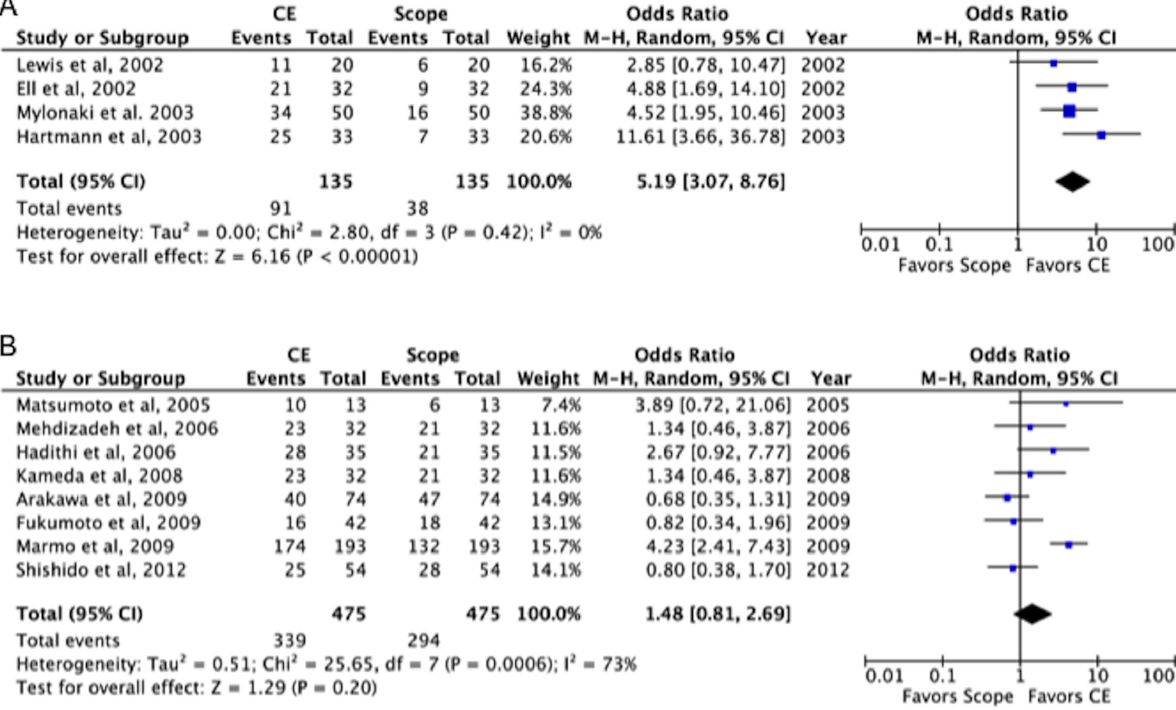
Fig 3. Forest plot of the odds ratio of OGIB detection in the premarketing and postmarketing settings. A: Premarketing setting. B: Postmarketing setting.